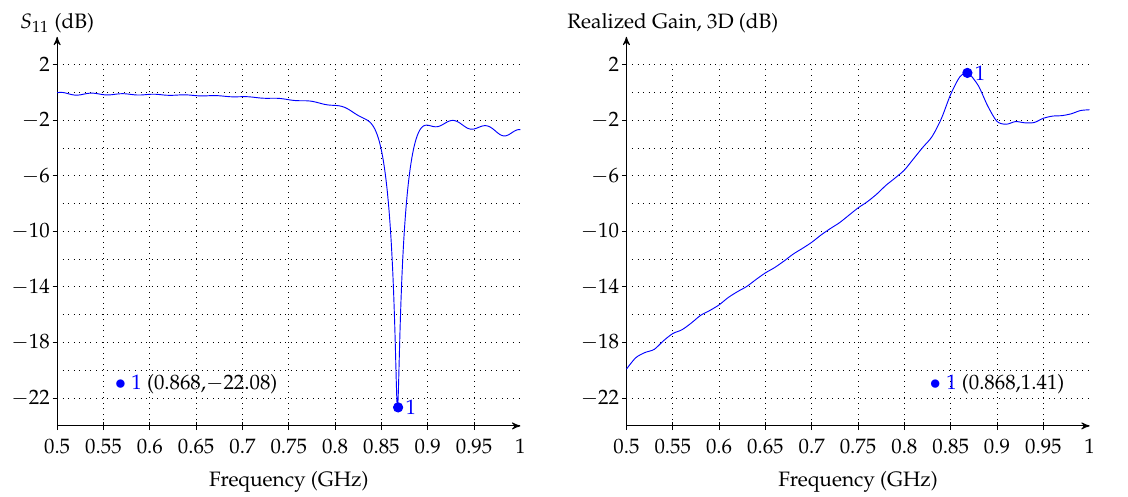
Figure 6. Performance results of the proposed Planar Crossed Dipoles. Reflection coefficient for isotropic radiation on the left. Realized Gain over frequency on the